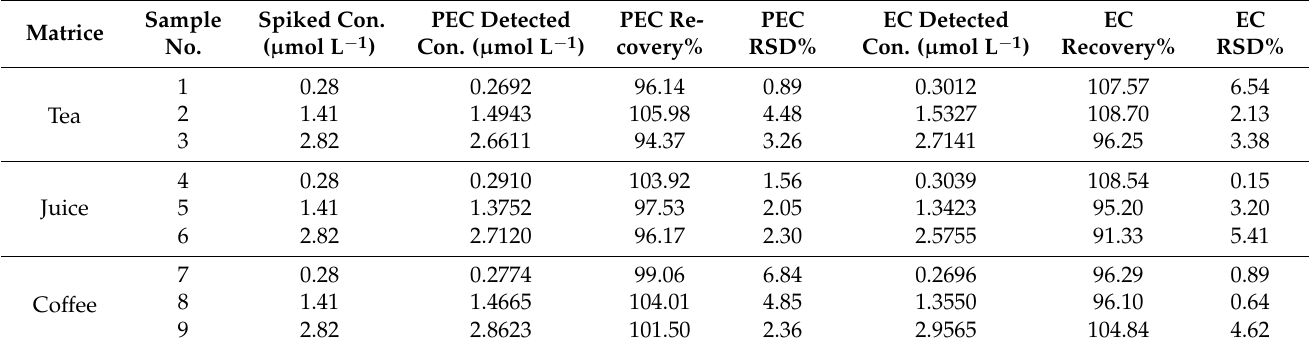
Table 2. Detection of real samples by the dual-mode sensor platform.